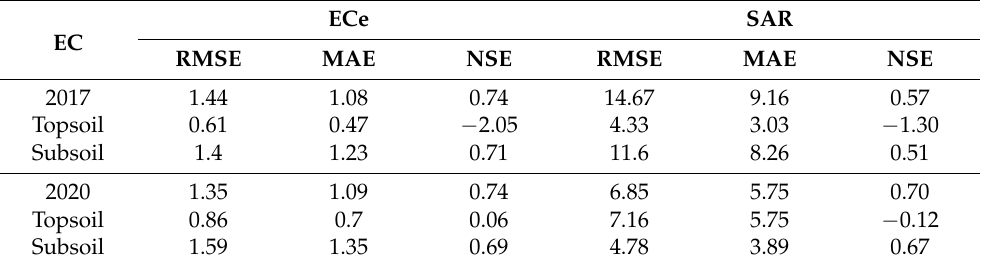
Table 4. Leave-one-out cross validation parameters for the estimation of ECe and SAR in 2017 and 2020, distinguishing between top- (0.1 and 0.3 m layers) and subsoil (0.5–0.9 m layers).